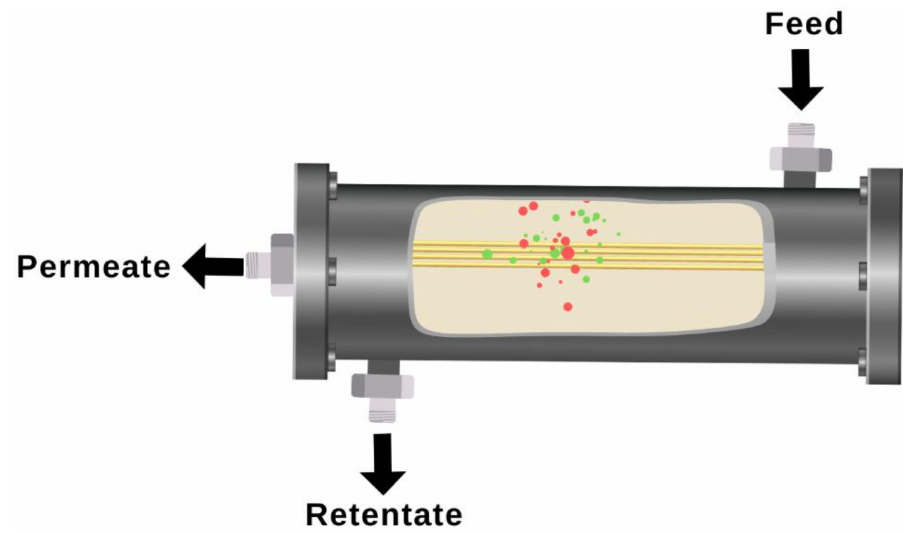
Figure 1. Schematic diagram of the gas permeation test